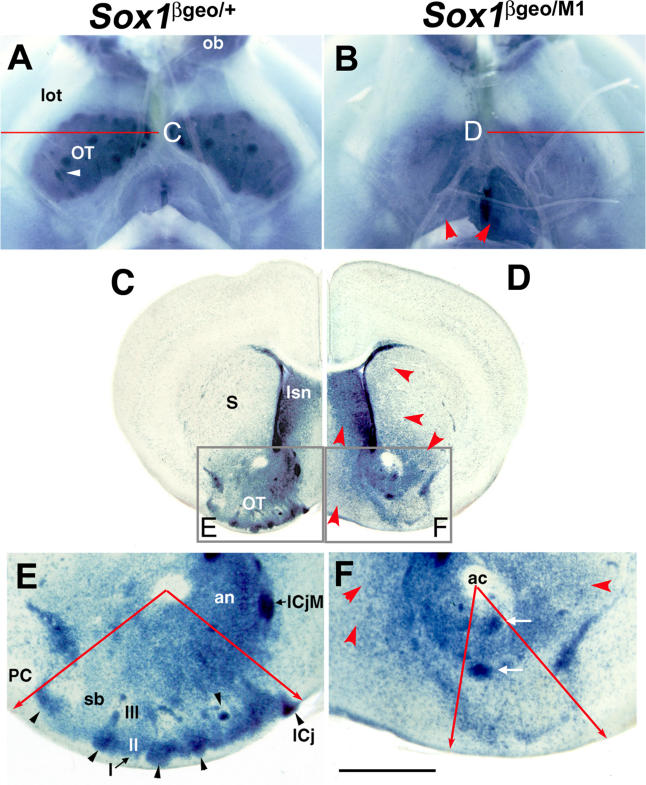
Ectopic Distribution of Sox1-Null NeuronsX-gal staining of mouse forebrains at P16. (A and B) show intact forebrain viewed from the ventral surface, and (C–F) show 150-μm coronal Vibratome sections for Sox1
βgeo/+ mice (A, C, and E) and Sox1
βgeo/M1 mice (B, D, and E). Red arrows indicate the width of the OT. Red arrowheads indicate increased X-gal staining at more medial and posterior areas of the brain in (B), and in the striatum and septum in (D) and (F). White arrowheads indicate islands other than the medial islands of Calleja. an, accumbens nucleus; I, II, III, cell layers of the OT; ICjM, medial islands of Calleja; lot, lateral olfactory tract; lsn, lateral septal nucleus; ob, olfactory bulb; PC, olfactory (piriform) cortex; S, striatum; sb, striatal bridge Scale bar = 500 μm.